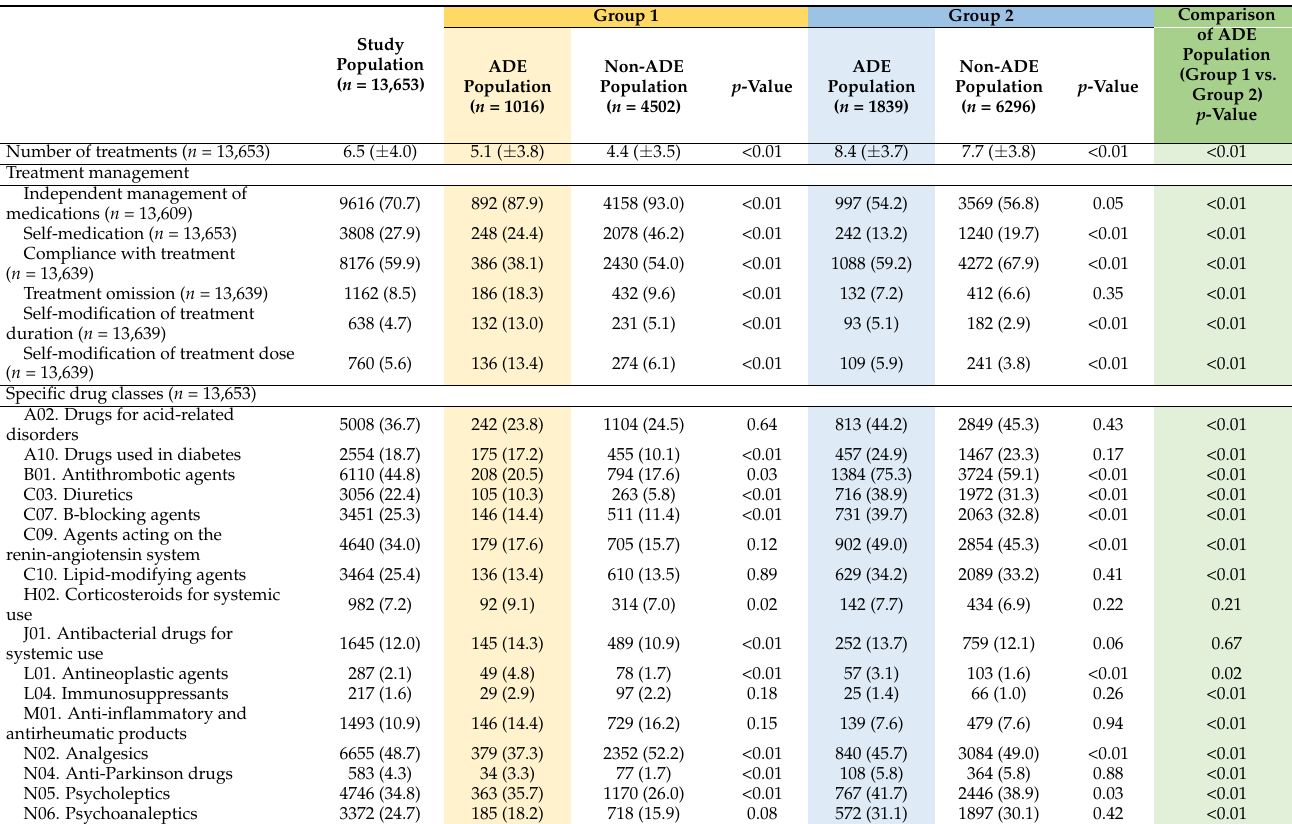
Table 2. Therapeutic data by age group and presence/absence of an ADE. Group